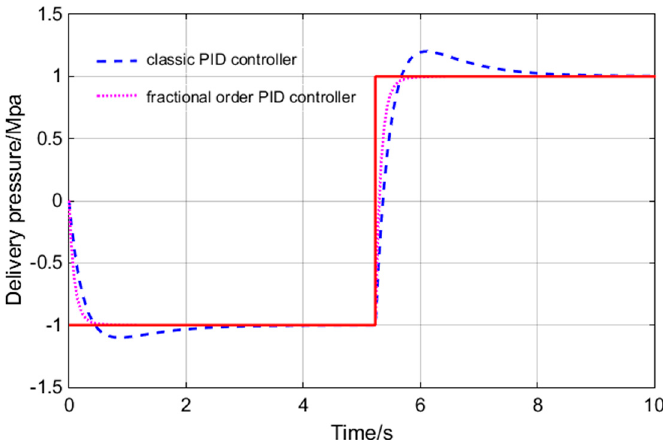
Figure 10. Square wave input signal tracking response. Figure 10. Dynamic curve diagram of real time data.